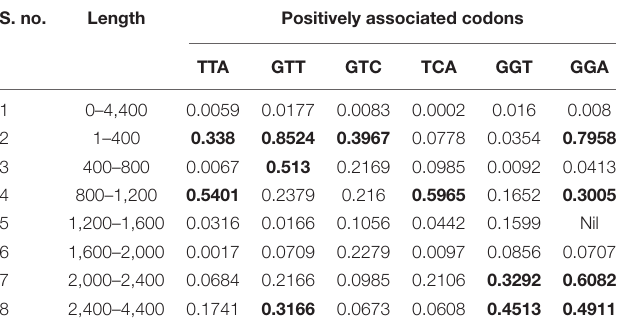
TABLE 3 | R-squared values ( R 2 ) ≥ 0.25 are shown in